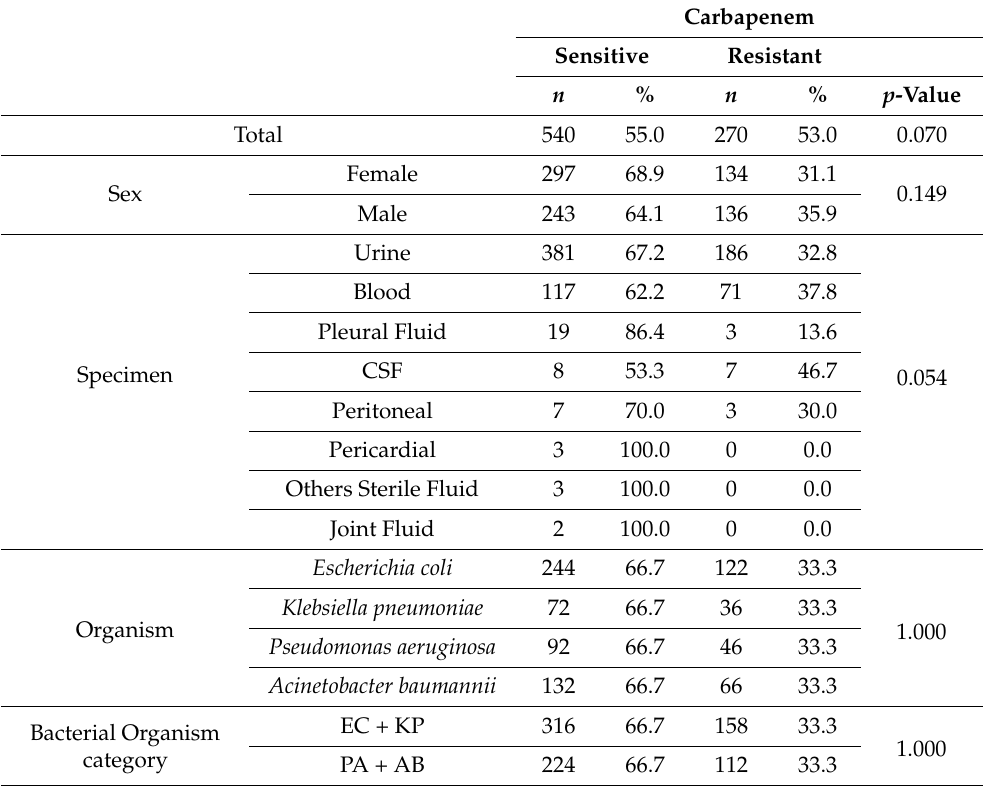
Table 1. Distribution of cases by gender, specimen, organism, and outcome as per carbapenem